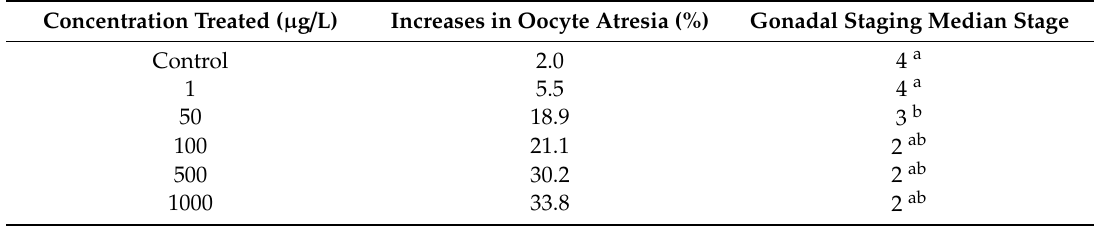
Table 1. Histopathologic analyses of the ovary of Javanese medaka ( O. javanicus ) exposed to sublethal Diuron during 3 w with the percentages of atresia and median gonadal staging ( n = 36). Concentration Treated ( µ g / L) Increases in Oocyte Atresia (%) Gonadal Staging Median Stage Control 2.0 4 a 1 5.5 4 a 50 18.9 3 b 100 21.1 2 ab 500 30.2 2 ab 1000 33.8 2 ab ab —indicates a significant di ff erence ( p < 0.05) between the